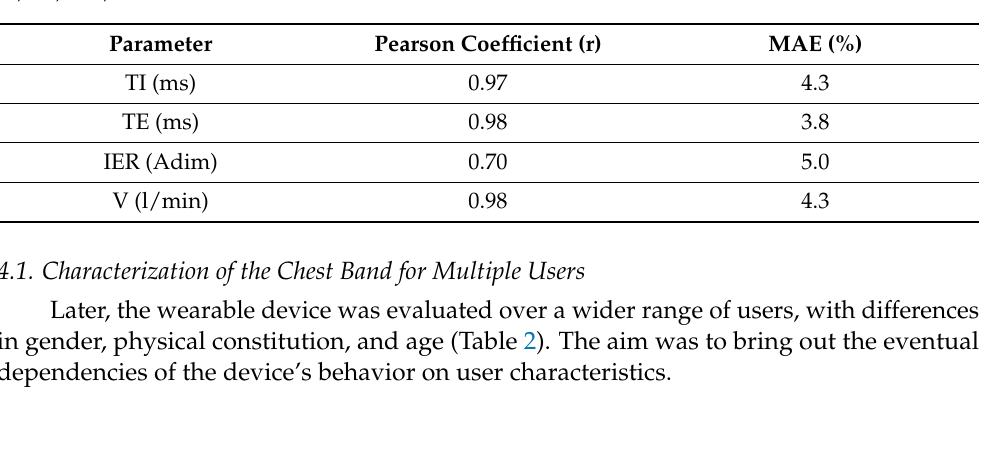
Table 5. Summarizing table reporting on the performance of the developed chest band in detecting TI, TE, IER, and